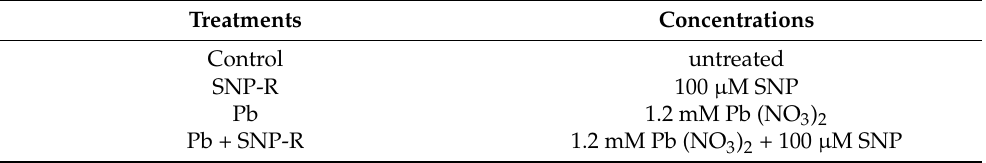
Table 1. Demonstrates different treatments and concentrations of the chemicals used in this study. Treatments Concentrations